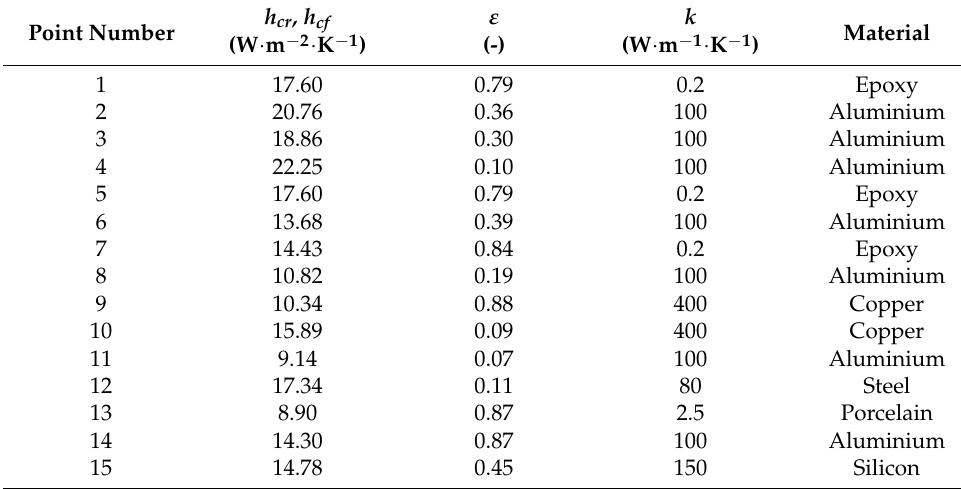
Table 3. Values of the convection coefficient for cylinder h cr , convection coefficient for the flat surface h cf , the value of emissivity coefficient ε , thermal conductivity value, and selected material used in the simulation, where the power dissipated on the P j junction was 8.17 W ( ∆ P j = 0.63